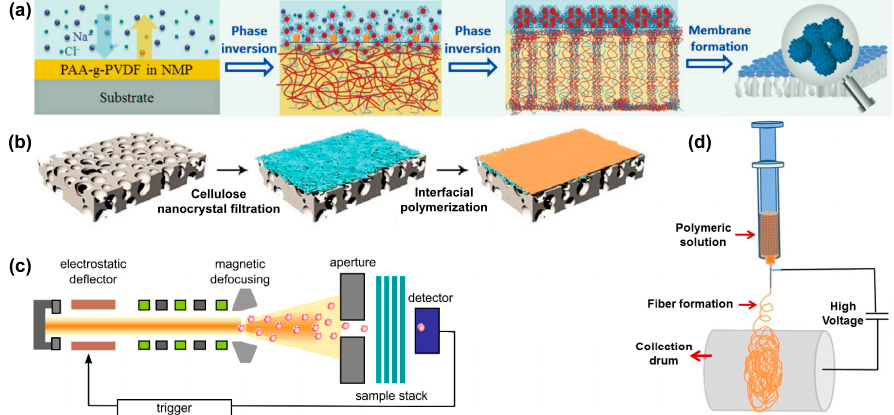
Figure 1. Fabrication strategies of various nanoporous membranes: ( a ) Formation of a superoleophobic PAA-g-PDVF membrane by a salt-induced phase-inversion process; ( b ) Preparation of triple-layered thin film composite (TFC) nano-filtration membrane by interfacial polymerization; ( c ) Schematic of single-ion irradiation setup; and ( d ) Schematic of electrospinning. Picture ( a ) is reprinted